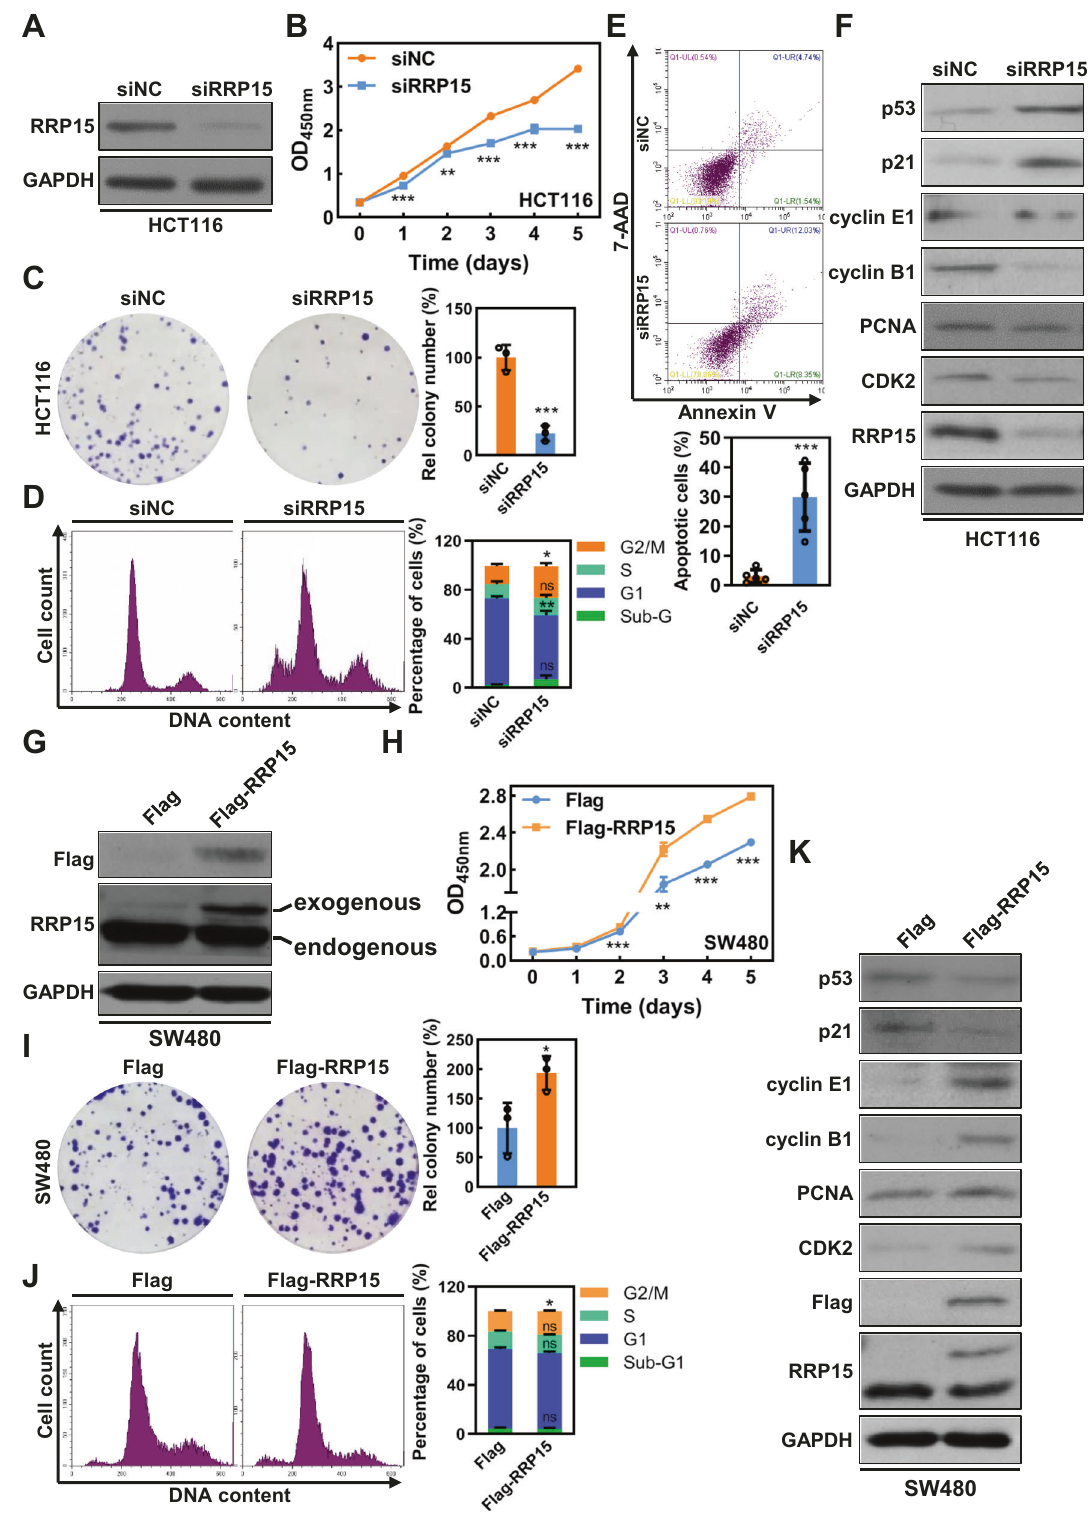
control cells, a decreased expression of mesenchymal markers (Vimentin, N-cadherin and MMP9) and an increased expression of epithelial marker E-cadherin were observed in RRP15 KD cells (Figs. 3C and S6A). Meanwhile, RRP15 OE enhanced the migration and invasion capacity of CRC cells, increased the expression